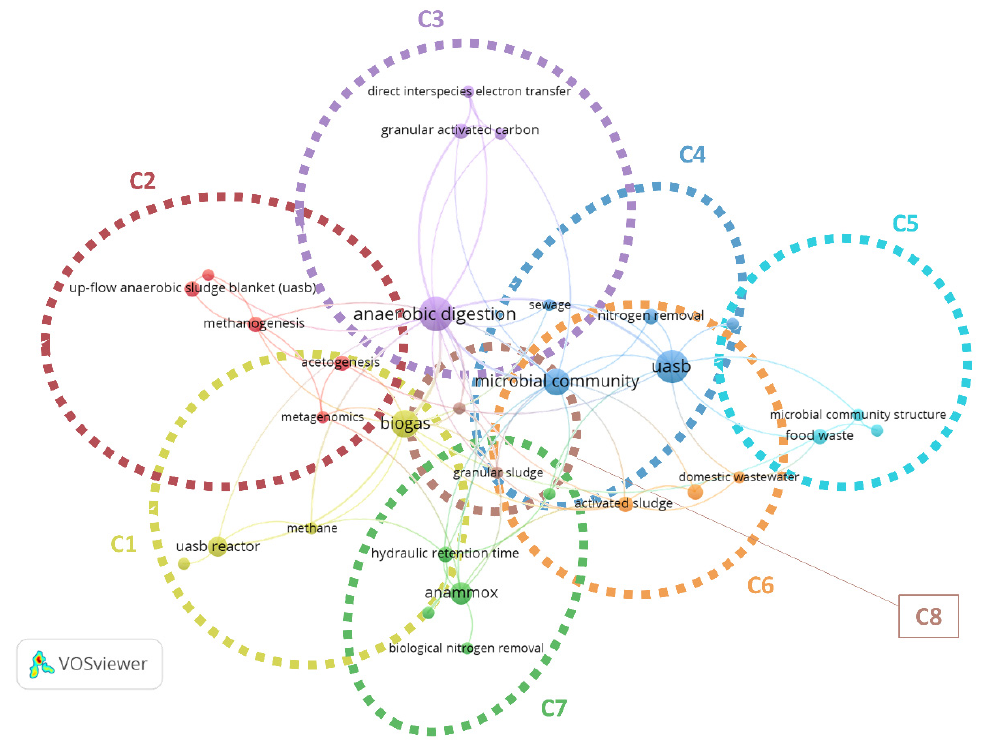
Figure 4. Network visualization of co-occurrences by author keywords of records in G2. A diverse colour represents a diverse cluster. Cluster analysis and graphic representation were made using VOSviewer software. C: cluster.